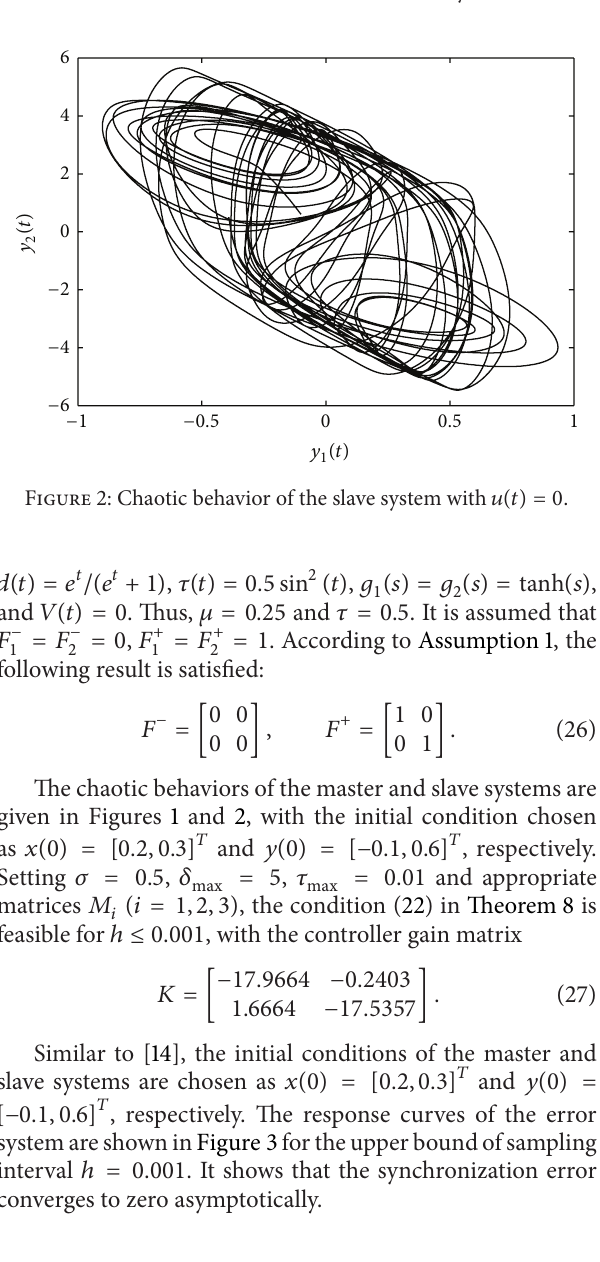
Figure 1: Chaotic behavior of the master system.